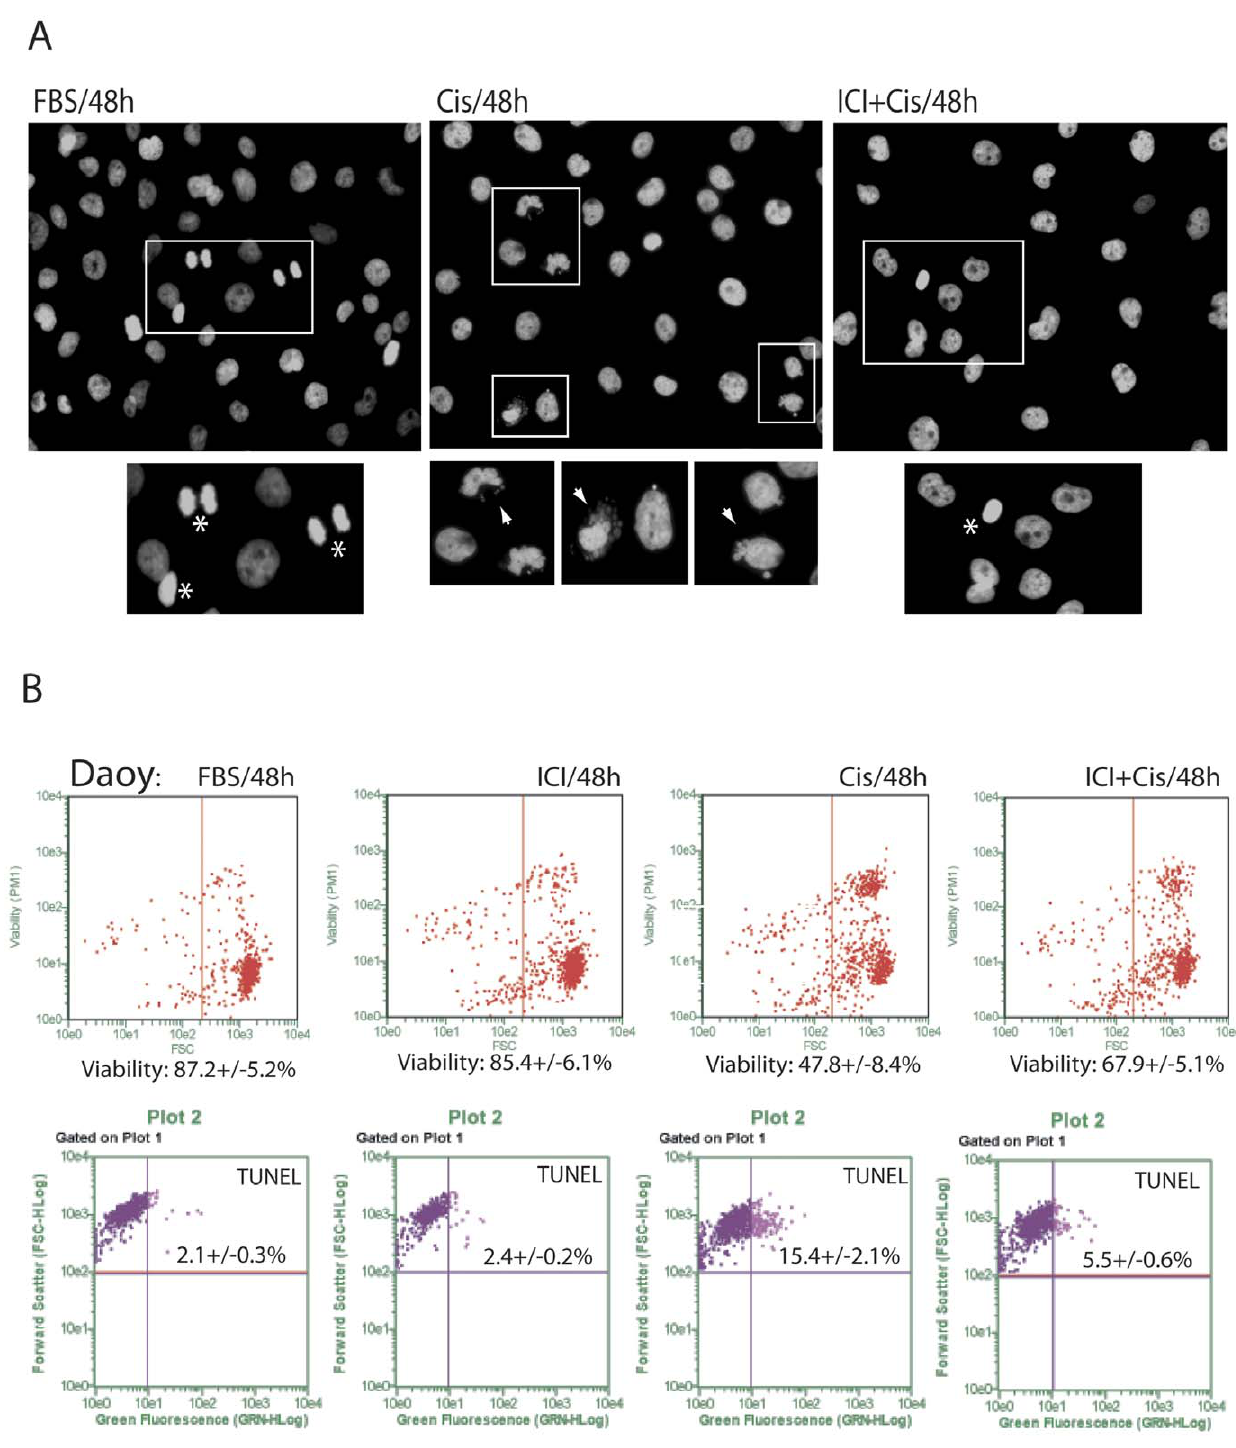
Figure 1. Inhibition of ER b improves cell survival in the presence of cisplatin. Panel A: Fluorescent images showing nuclear morphology following labeling of DNA by fluorescent dye 4 9 ,6-diamidino-2-phenylindole (DAPI). Exponentially growing monolayer cultures of Daoy cells (10%FBS) were treated with cisplatin (1 m g/ml) or with cisplatin + ICI182,780 (10 m M) for 48 hours. The images were taken with Nikon Eclipse 400 upright fluorescent microscope equipped with the motorized Z-axis, EXI-Aqua camera and deconvolution software (SlideBook5). Rectangles indicate magnified area containing cells in mitosis (asterix); and cells with damaged nuclei (arrowhead). Note that abundant presence of micronuclei (arrow) and nuclear fragmentation in cisplatin, and much less of the nuclear damage in cells treated by cisplatin + ICI182,780. Original magnification 6 20. Panel B: Daoy cell viability evaluated by ViaCount and TUNEL assays. Both assays were adopted for the use with the GUAVA easyCyte 8HT flowcytometer (Millipore). The Guava/Express Plus and Guava/ViaCount software were used for data analysis and quantification according to the manufacturer recommendations (Millipore).